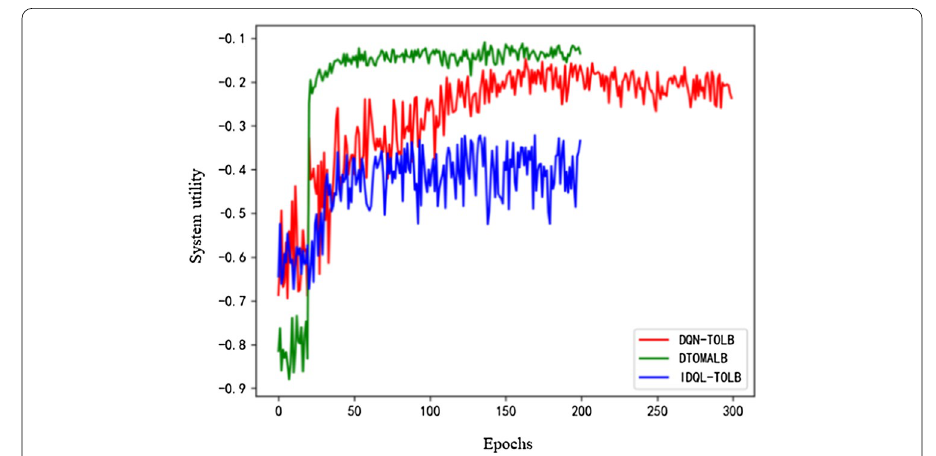
Fig. 5 The convergence of the algorithm